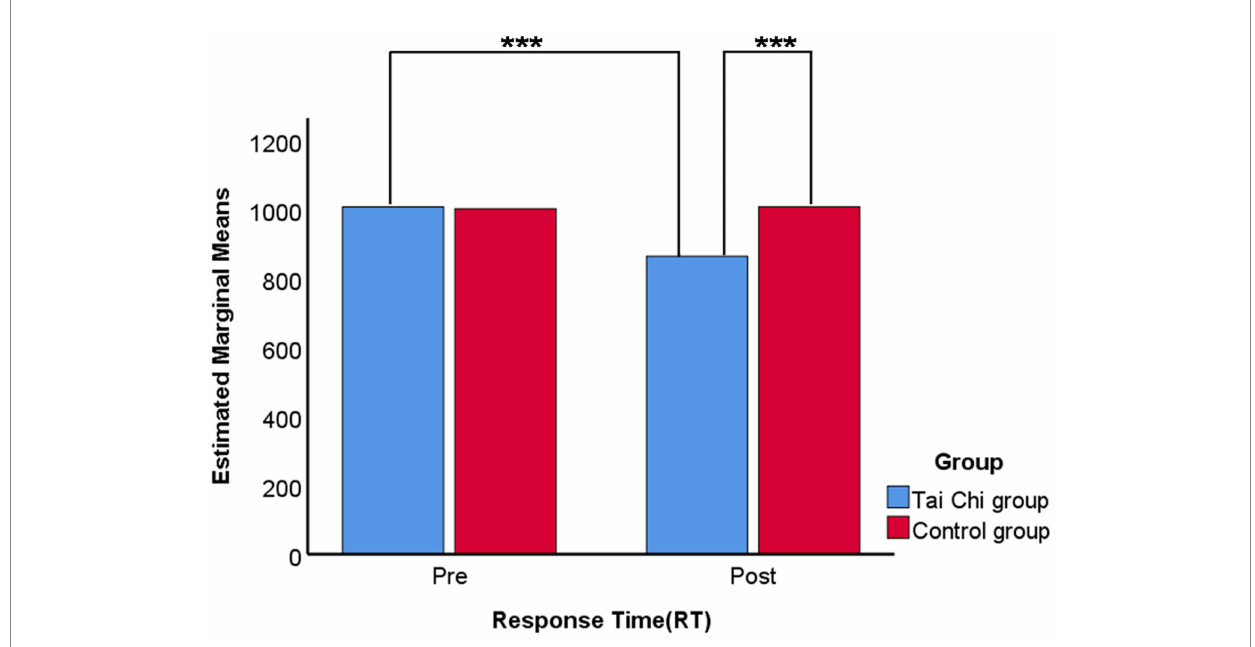
FIGURE 5 Paired comparison of Response Time (RT) on visual working memory tests. Bonferroni adjustment for multiple comparisons. *** p -value <0.001.